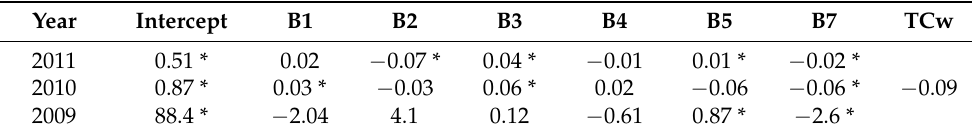
Table 4. Estimators of the regression models for grass